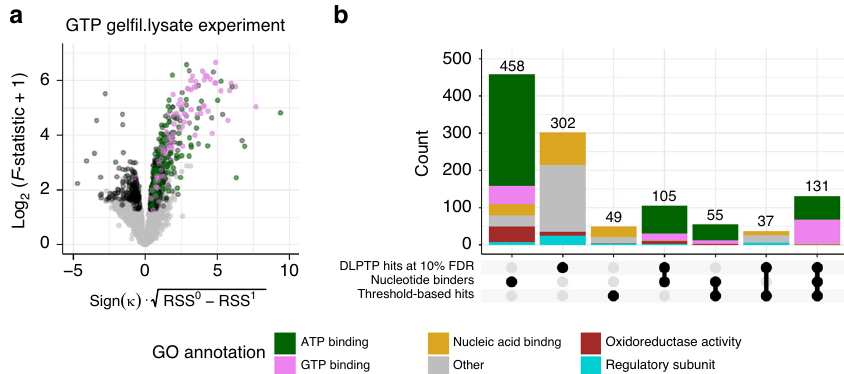
Fig. 5 DLPTP recovers annotated GTP and ATP interactors from a 2D-TPP experiment pro fi ling GTP – protein interactions. a Volcano plot for the analysis of the GTP gel- fi ltered lysate dataset. b Upset plot of set intersections of annotated nucleotide-binding proteins, stabilized hits found with the threshold-based approach, and stabilized hits found by DLPTP. Axes in a are outlined in